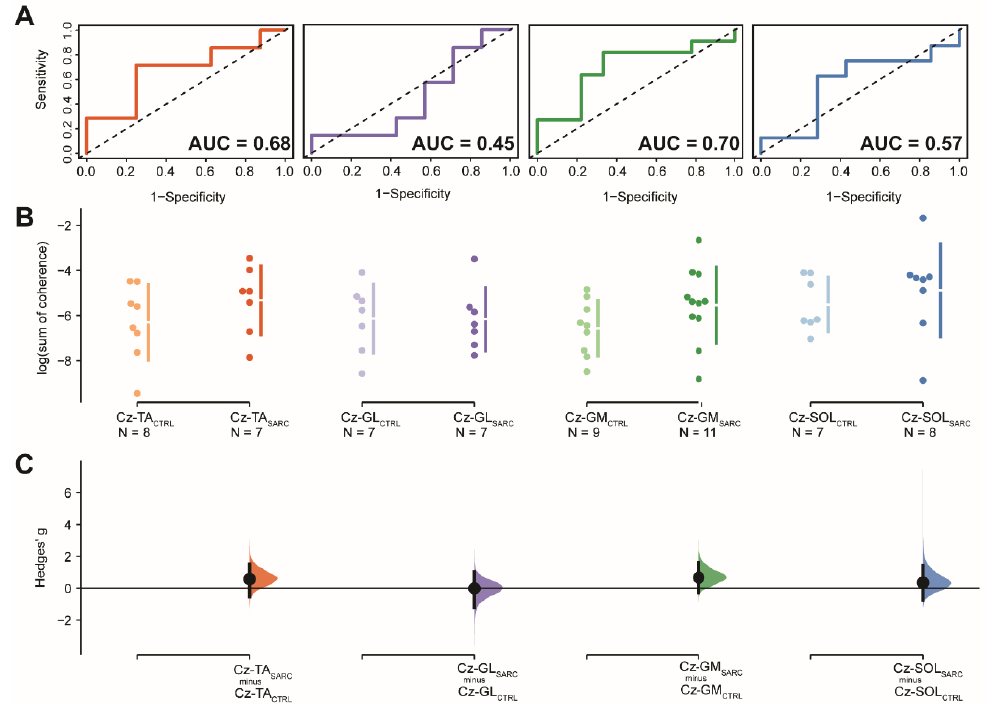
Figure 4. Results relative to the log-transformed coherence area (sum of coherence above significant confidence limits) between the EEG Cz sensor and the muscles located in the lower part of the lower limb: Tibialis Anterior (Cz-TA), Gastrocnemius Lateralis (Cz-GL), Gastrocnemius Medialis (Cz-GM) and Soleus (Cz-SOL). ( A ) shows the ROC curve with the respective accuracy (i.e., AUC estimate) depicted within the plot, precision (i.e., 1-specificity) shown on the x -axis while sensitivity presented in the y -axis. The dotted diagonal line depicts the 50% chance of differentitating between sarcopenic and non-sarcopenic older adults. ( B ) Cumming estimation plots showing mean differences of the log-transformed coherence area plotted in the upper axes separately for both sarcopenic (SARC, darkish color) and healthy control older adults (CTRL, lightish color). Each mean difference is represented by dots and plotted on the ( C ) lower axes as a bootstrap sampling distribution, while the ends of the vertical error bars denote the 95% confidence intervals.